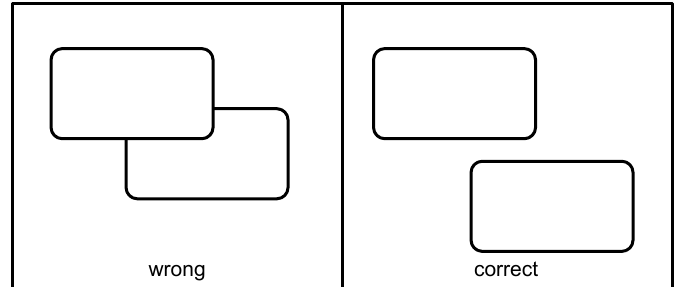
Figure 4.1: Nodes must not overlap.